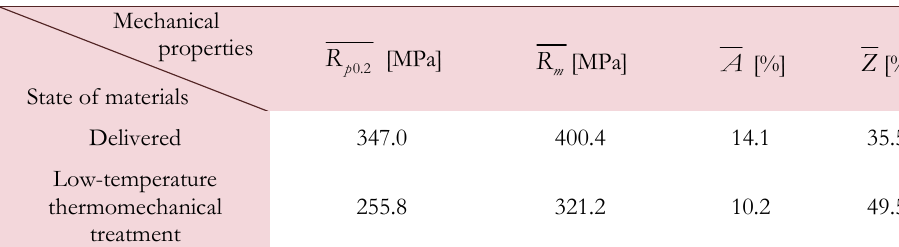
Table 2: Mechanical properties of investigated